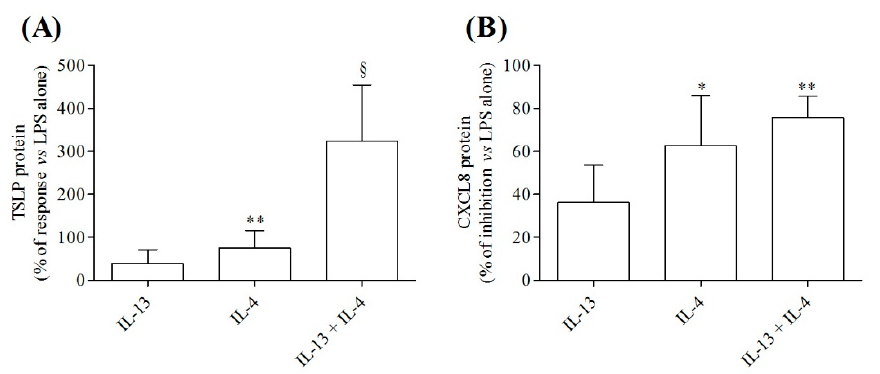
Figure 3. Effects of IL-13 and IL-4, alone or in combination, on TSLP and CXCL8 release from LPS- activated HLMs. Highly purified HLMs (1.5 × 10 5 cells/well) were preincubated (10 min, 37 °C) with IL-13 (10 ng/mL) or IL-4 (10 ng/mL), alone or in combination, before the stimulation with LPS (100 ng/mL). TSLP ( A ) and CXCL8 ( B ) proteins in supernatants were evaluated by ELISA. Data are mean ± SD of 6 independent experiments obtained from different patients. * p < 0.01, ** p < 0.001 and § p < 0.0001 vs. LPS alone.